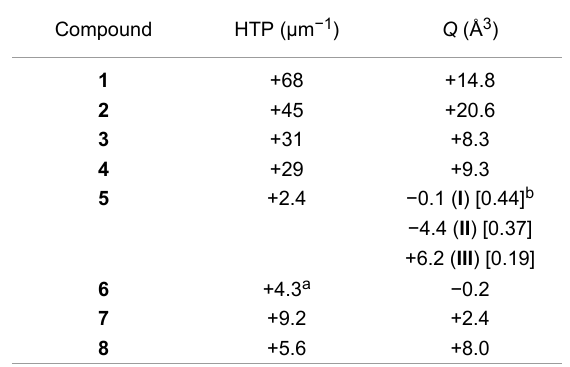
Table 1: Helical twisting power (HTP) measured in the nematic host E7 and chirality parameter Q calculated by the SC